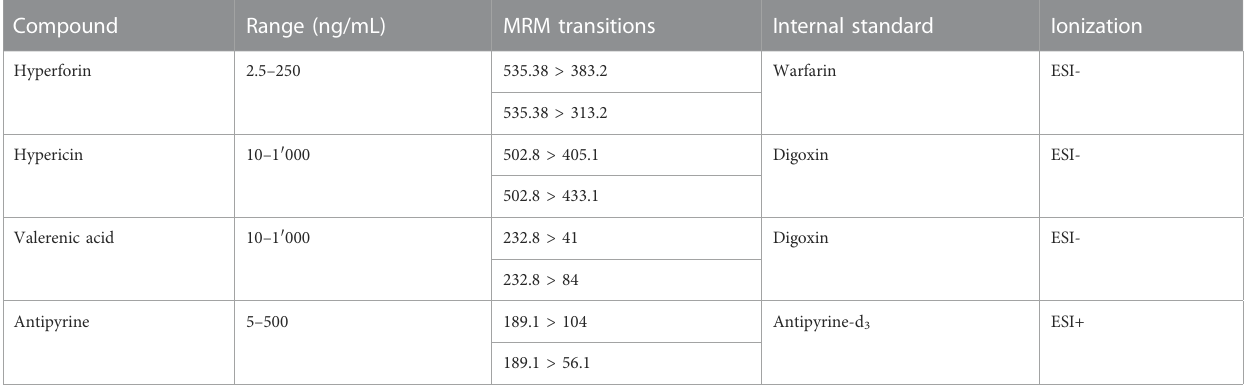
TABLE 1 ESI-MS conditions for the analysis of test compounds.